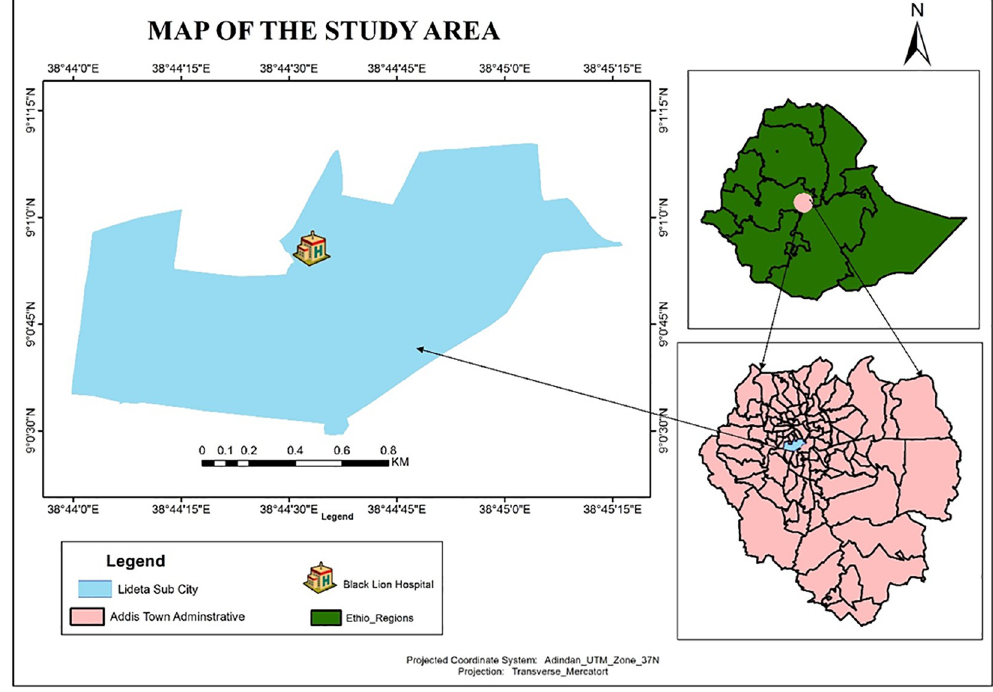
Fig 1. Map of Addis Ababa and the location of black lion specialized hospital, in Addis Ababa, Ethiopia.